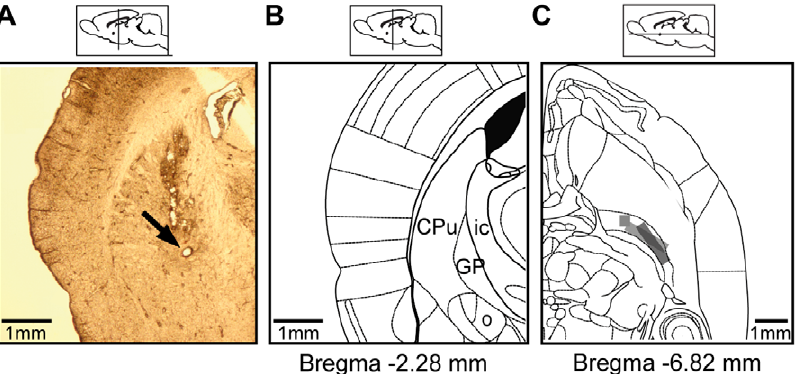
Figure 1. Verification of electrode placement in the Globus Pallidus of rats. A: a 60 micron slice showing electrode placement in a rat GPe following electrolytic lesion. B: Appropriate coronal section from atlas (Bregma: 2 2.28 mm; [47]). C: Recording sites marked (grey rectangle) for all animals on a planar rat atlas slice (Bregma: 2 6.82 mm; [47]).